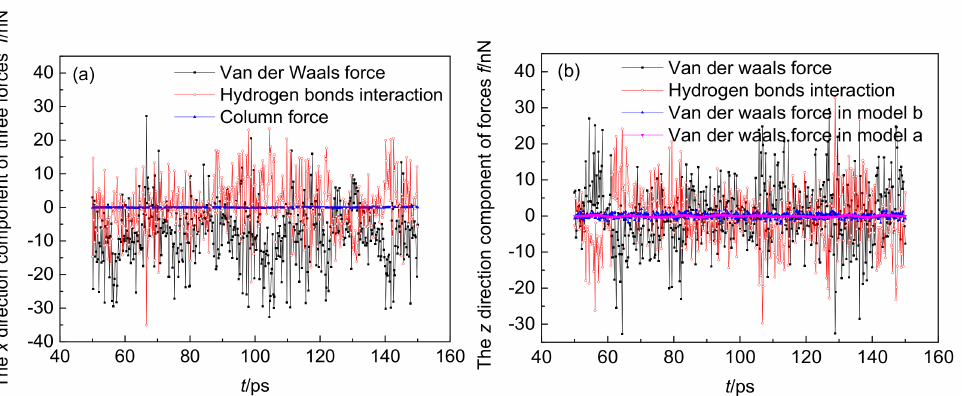
Figure 4. ( a ) The x direction component of van der Waals forces, Coulomb’s forces and hydrogen bond interactions between interfaces in model c; ( b ) The z direction component of van der Waals force in models a, b, c, and the z direction component of hydrogen bonds interaction in model